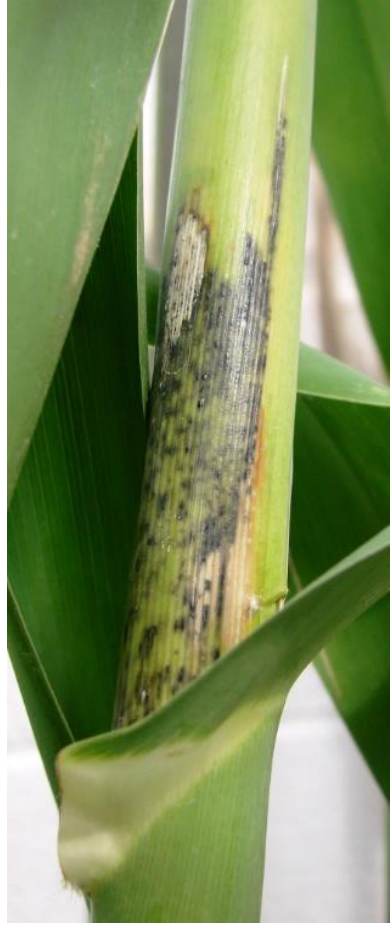
Figure 1. Late symptoms (i.e., black streaks inside leaf sheath of A. donax ) of attacks by L. donacis.